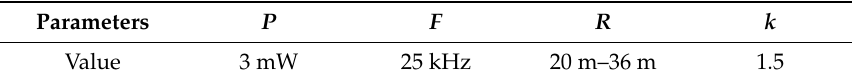
Table 3. Acoustic energy consumption